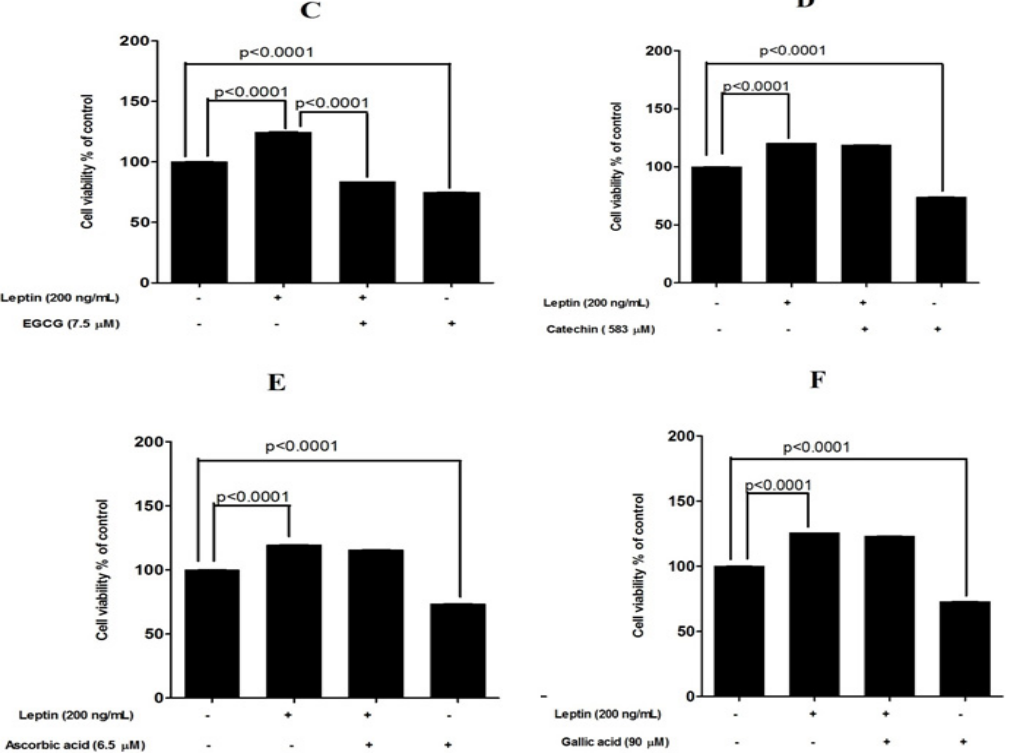
Figure 2. Protective effects exerted by six dietary compounds in leptin ‐ stimulated MCF ‐ 7 breast cancer cells examined by MTT assay. ( A ) quercetin ( B ) curcumin ( C ) EGCG ( D ) catechin ( E ) ascorbic acid and ( F ) gallic acid. ** p < 0.001, *** p < 0.0001 compared with leptin ‐ stimulated cells by one way ANOVA with Bonferroni test for selected pairs of columns.